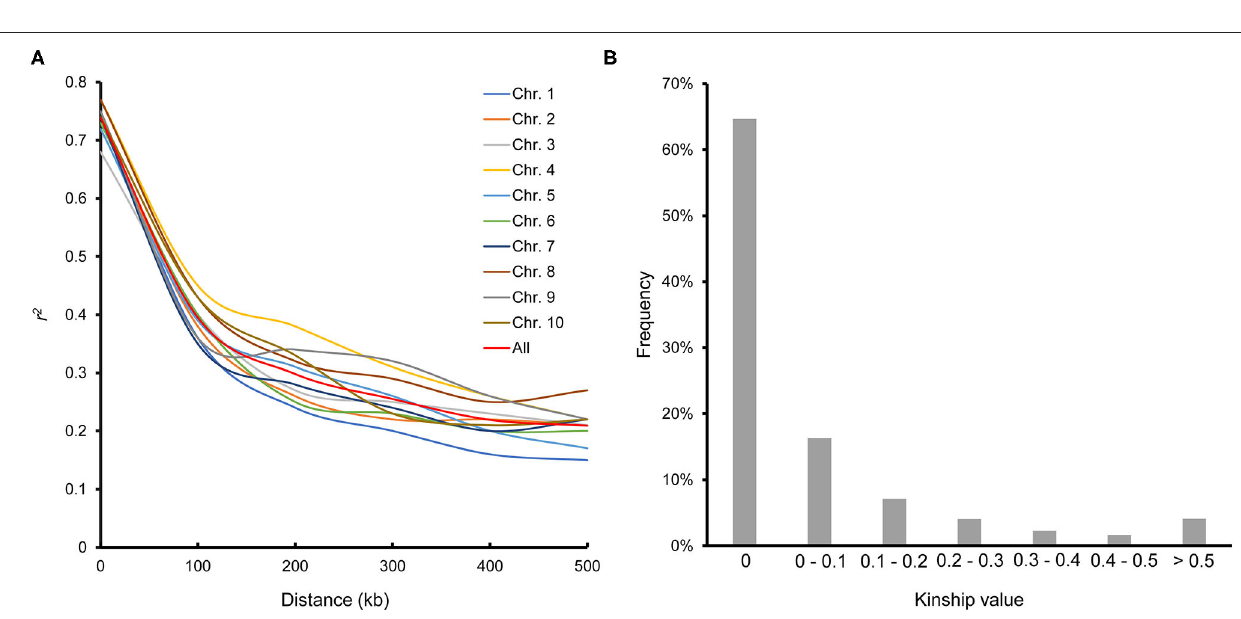
Eleven QTNs were considered to be stable; these were distributed on chromosomes 1, 2, 3, 5, 6, 7, 8, and 10 ( Table 2 ). Among the 11 stable QTNs, 11